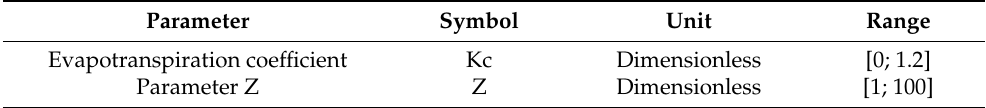
Table 7. Annual Water Yield model